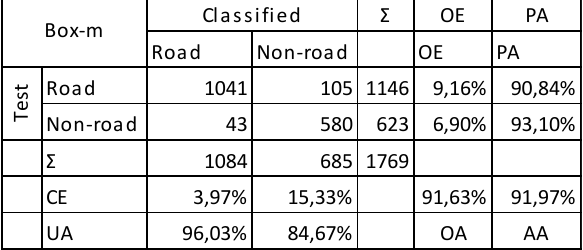
Table 3. In-sample accuracy for hyperbox classifier The best binary result (Fig. 4) of the hyperbox algorithm therefore was propagated into the next phase.